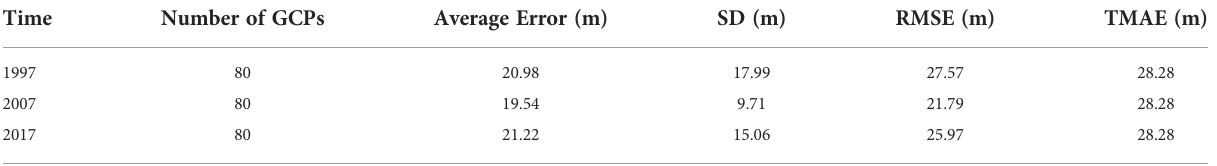
TABLE 3 Accuracy analysis results of the coastline extraction from remote sensing images in three periods.